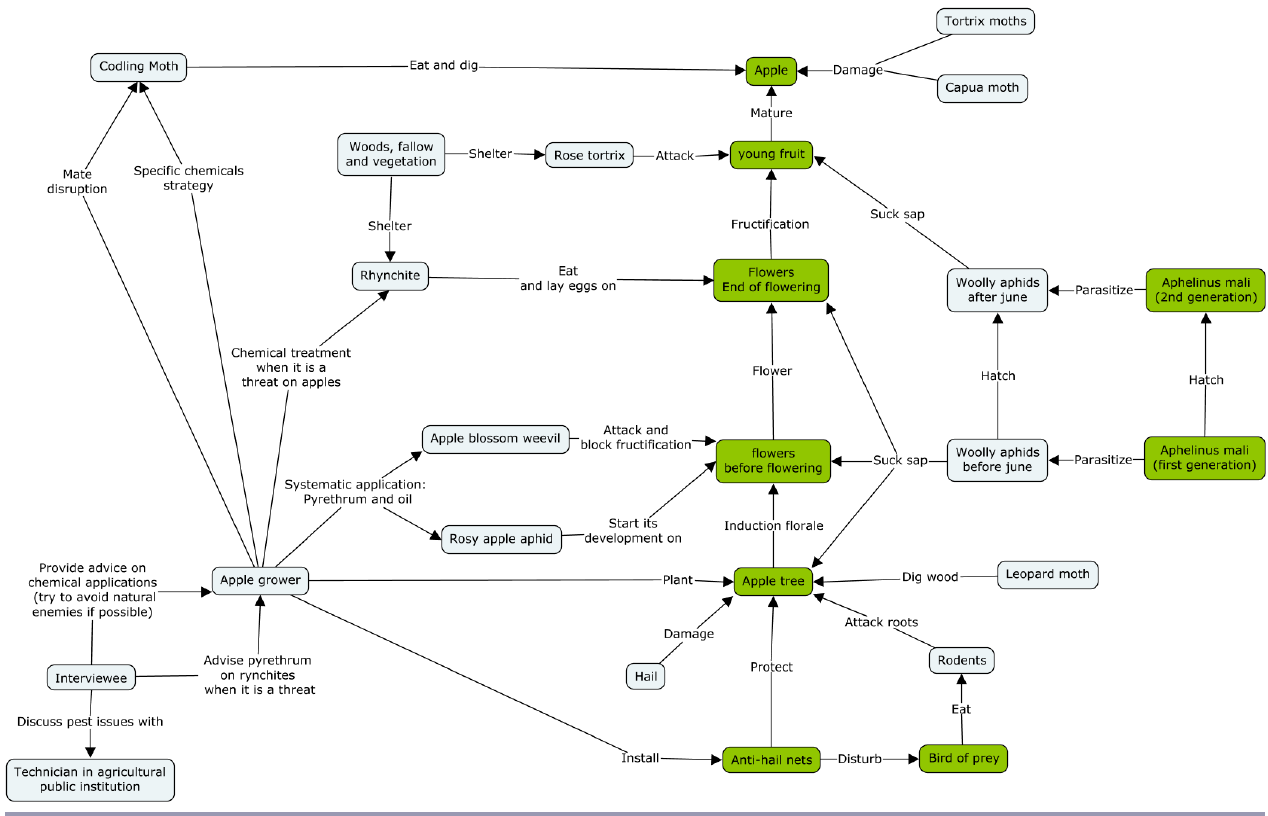
Fig. 2. Example of a mental model for a crop advisor in tree-fruit production using the ARDI (actors, resources, dynamics, interactions) ontology. Light blue = agents; green = resources. Arrows with text indicate the nature and orientation of the interaction between elements of the mental